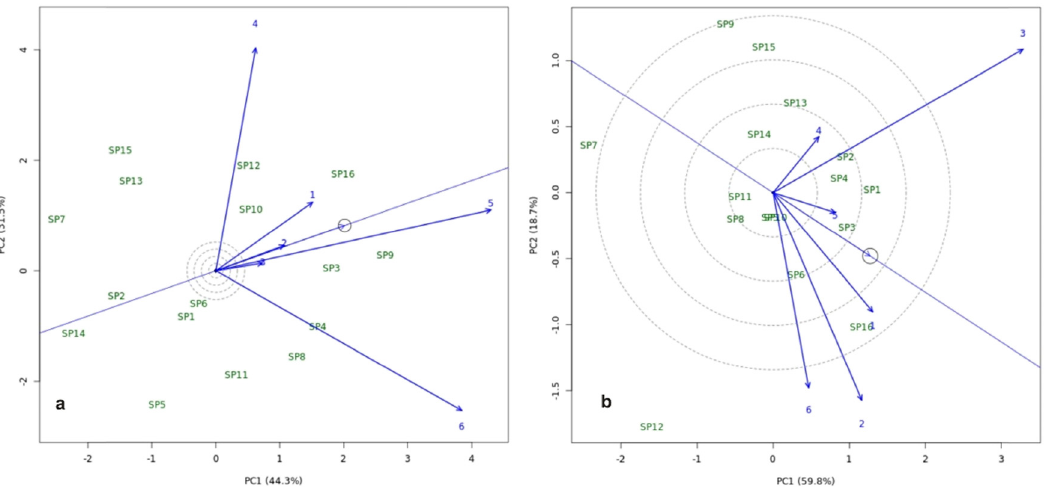
Figure 5: Biplot of 16 new honey sweet potato genotypes against average storage root yields and sweetness in six locations. ( a ) Storage root yield character and ( b ) sweetness character.